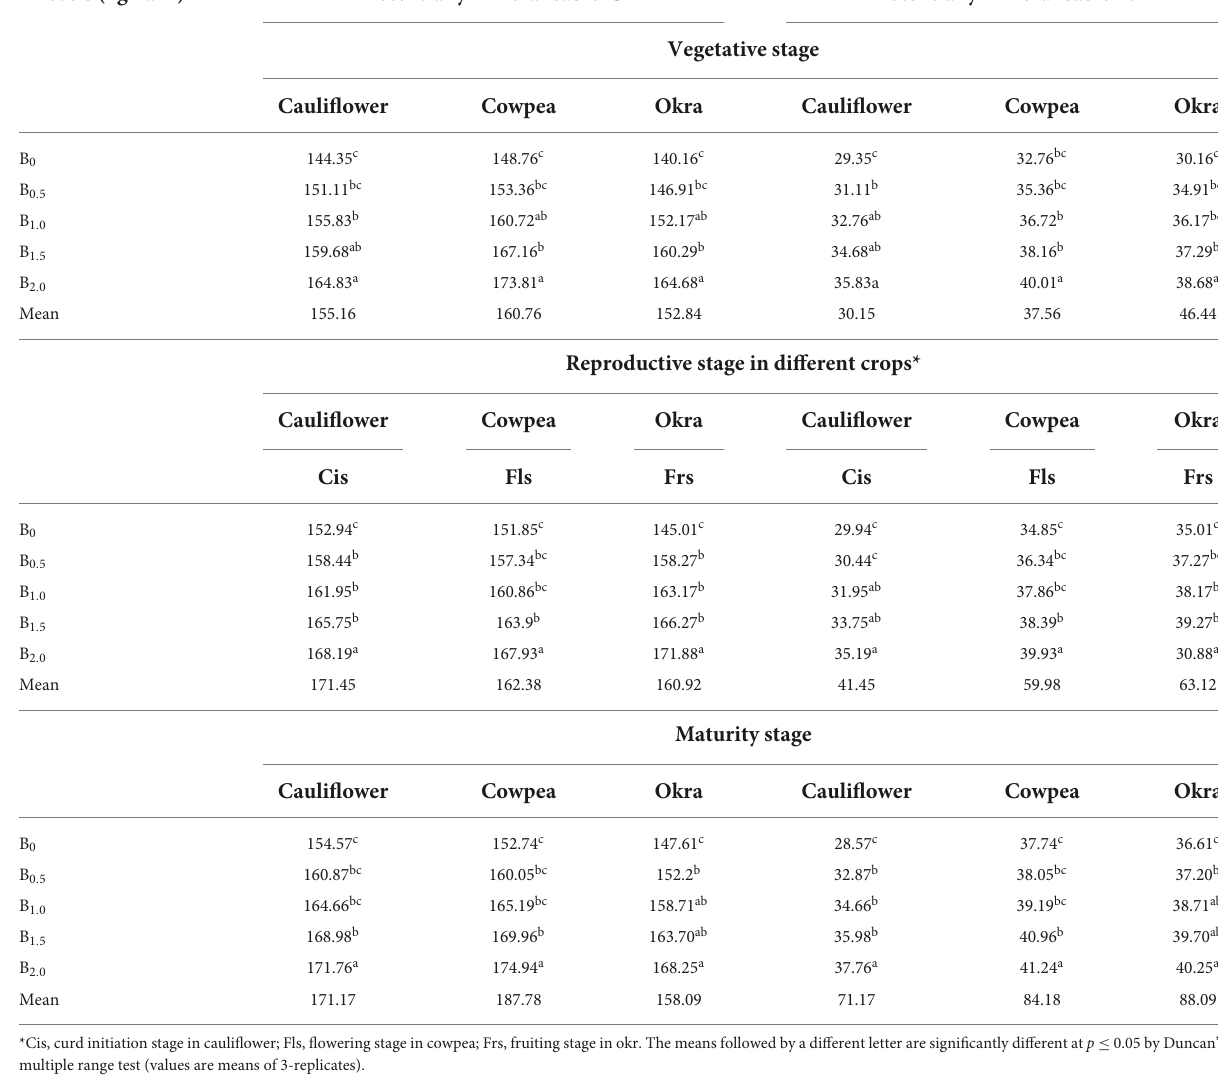
TABLE 3 Effect of graded B levels on PMN and PMC content in soil at different crop stages of cauliflower-cowpea-okra cropping system. B-levels (kg ha − 1